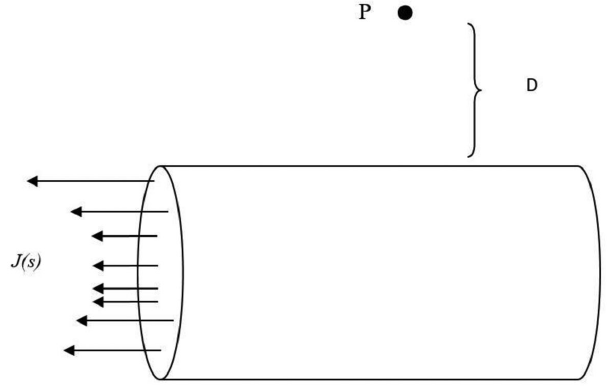
FIG. 11. Particle at point P is traveling in the direction opposite the current and remains parallel to the cylinder with a nonuniform current